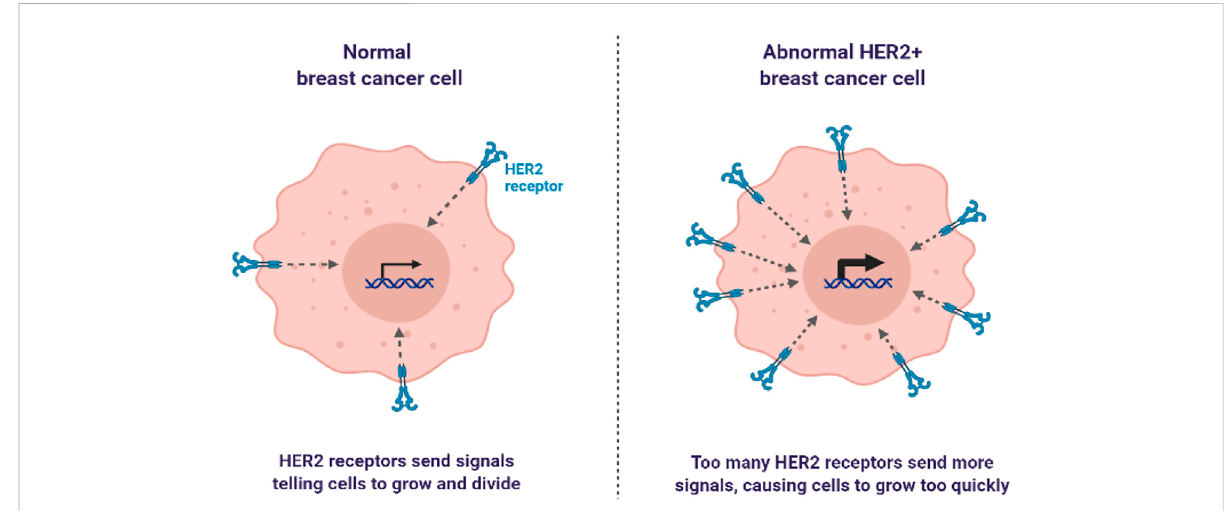
FIGURE 2 Representation of normal breast cancer cell and abnormal breast cancer